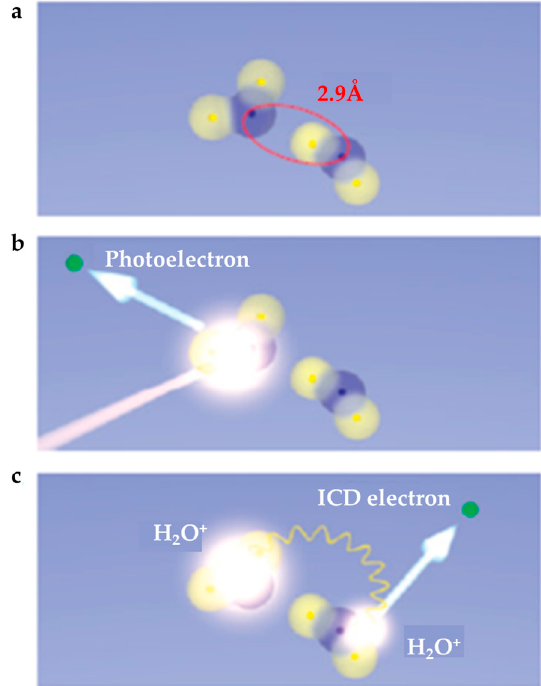
Figure 20. ( a ) Geometry of the water dimer. ( b , c ) An electron from the inner valence shell of one of the molecules of the dimer is ejected by absorption of a photon ( b ) and then the energy released by de-excitation at this site is transferred to the neighboring site, where a second, low-energy electron is emitted. Figure adapted from [58] with permission. Copyright 2010 Springer